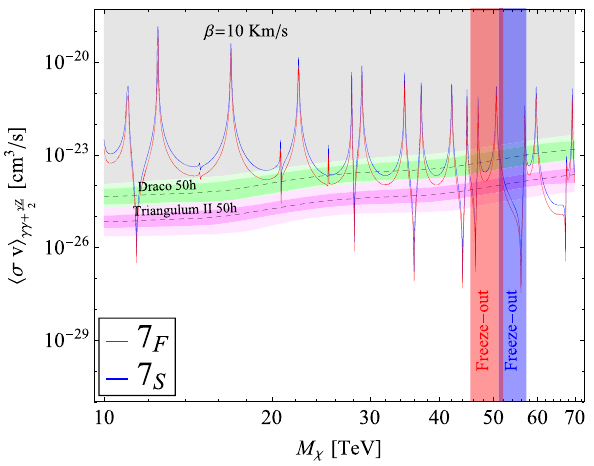
Fig. 7 Expected CTA sensitivities (dashed black lines) with 68% and 95% CL intervals derived as in Ref. [20] assuming 50 h observation time towards Draco (green) and Triangulum II (magenta). We show the SE annihilation cross-section into the channels that contribute to the monocromatic gamma line signal (i.e. γγ an γ Z ) for a scalar 7- plet (blue) and a fermionic 7-plet (red). The vertical bands show the predicted thermal masses for the scalar 7-plet (blue) and the fermionic 7-plet (red), where the theory uncertainty is dominated by the neglected NLO contributions (see Table